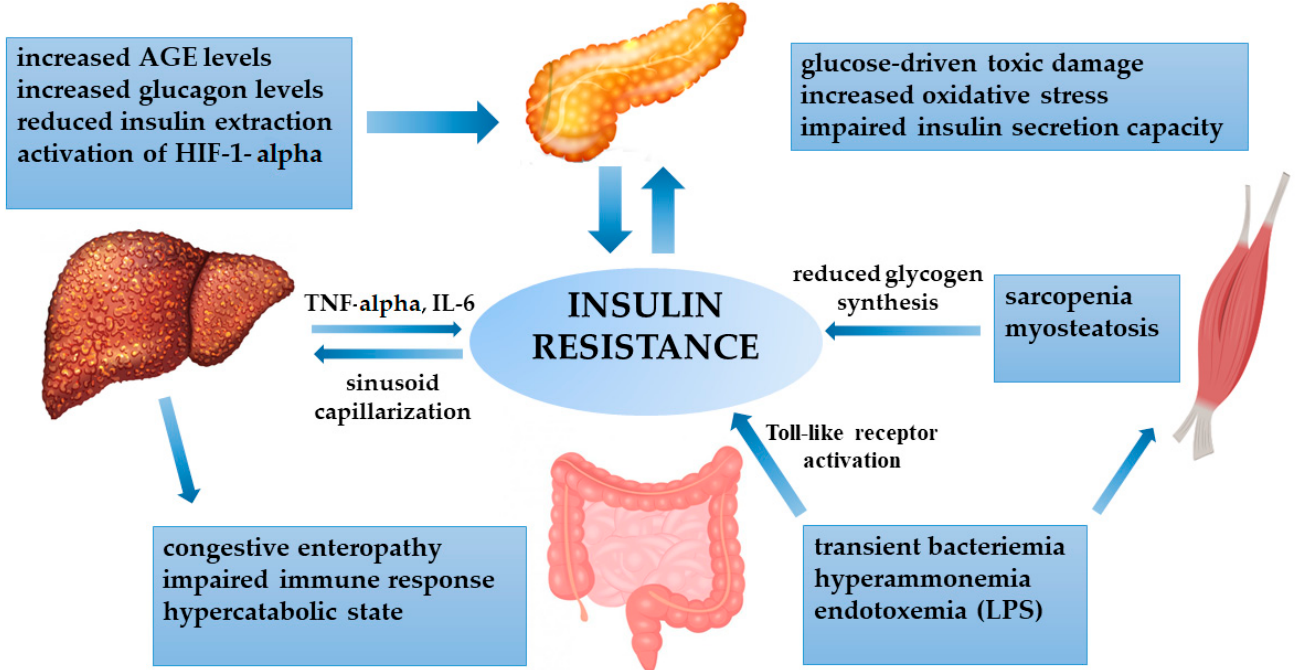
Figure 2. Crosstalk between the cirrhotic liver and peripheral tissues in determining insulin resistance. Abbreviations. Advanced glycation end product (AGE); hypoxia-inducible factor 1-alpha (HIF-1 α ); interleukin-6 (IL-6); lipopolysaccharide (LPS); tumor necrosis factor-alpha (TNF- α ).